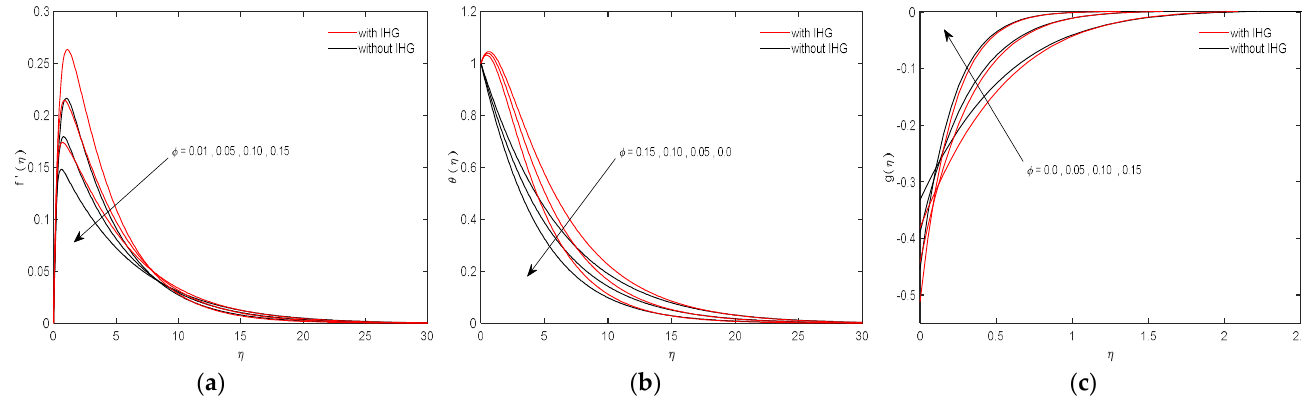
Figure 9. The effect of the nanoparticle volume friction parameter φ on the ( a ) velocity profile, ( b ) temperature profile and ( c ) angular velocity profile for R = 0.5, M = 2, λ = 0.5, c = 0, B = 0.2, Da = ( 10 ) , RD = 1, n = 0.5, fw =